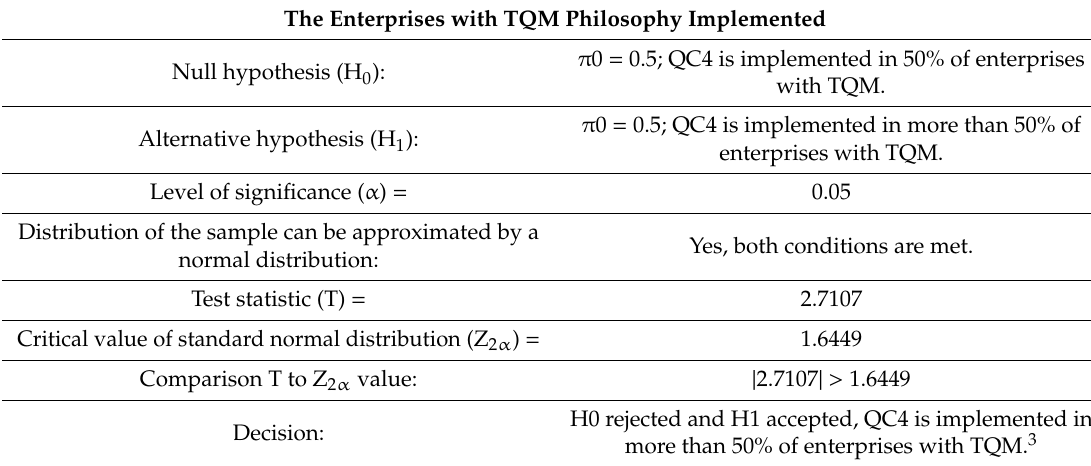
Table 9. The enterprises with TQM philosophy